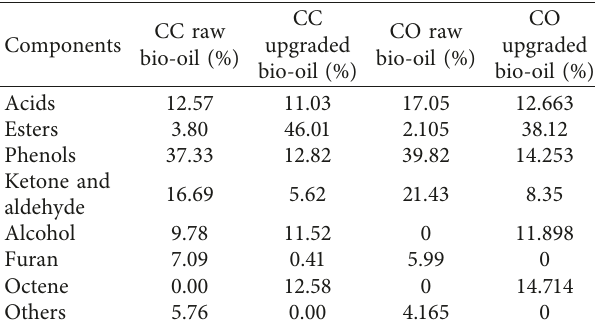
Table 5: Chemical composition of raw and upgraded bio-oil from